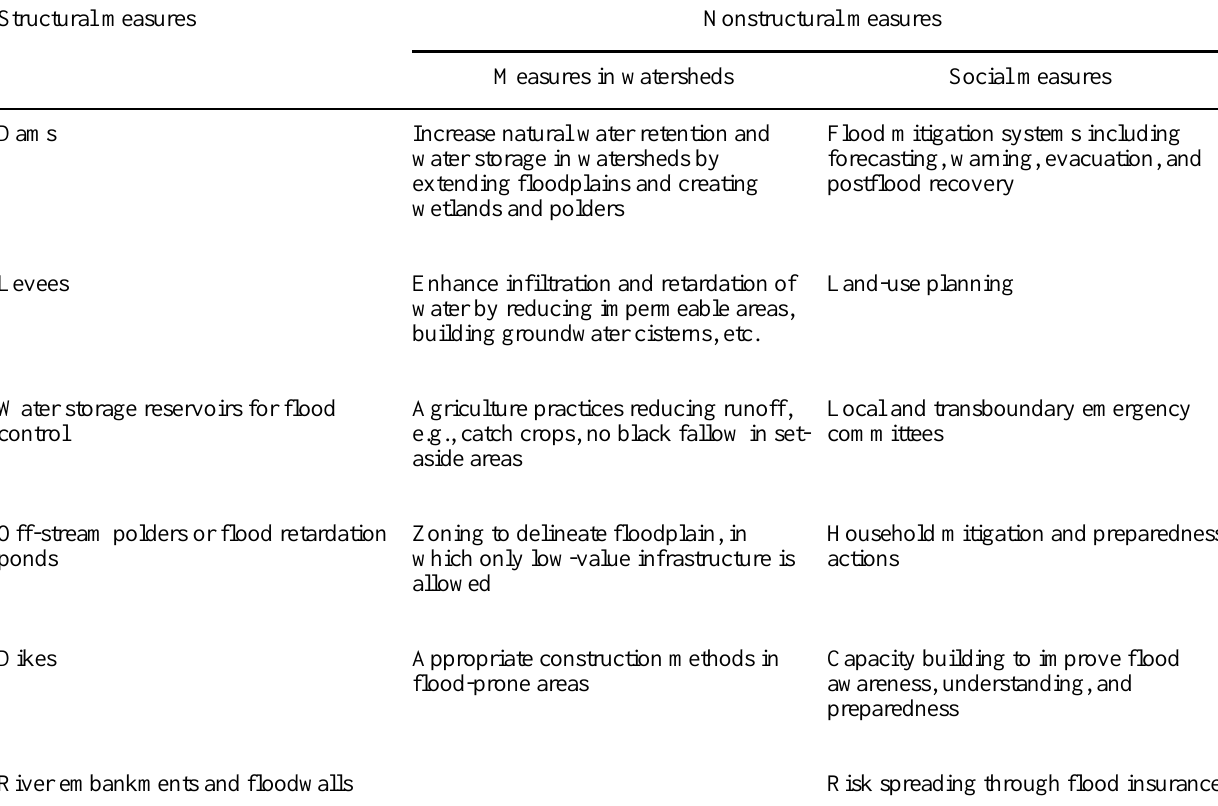
Table 1. Major flood protection